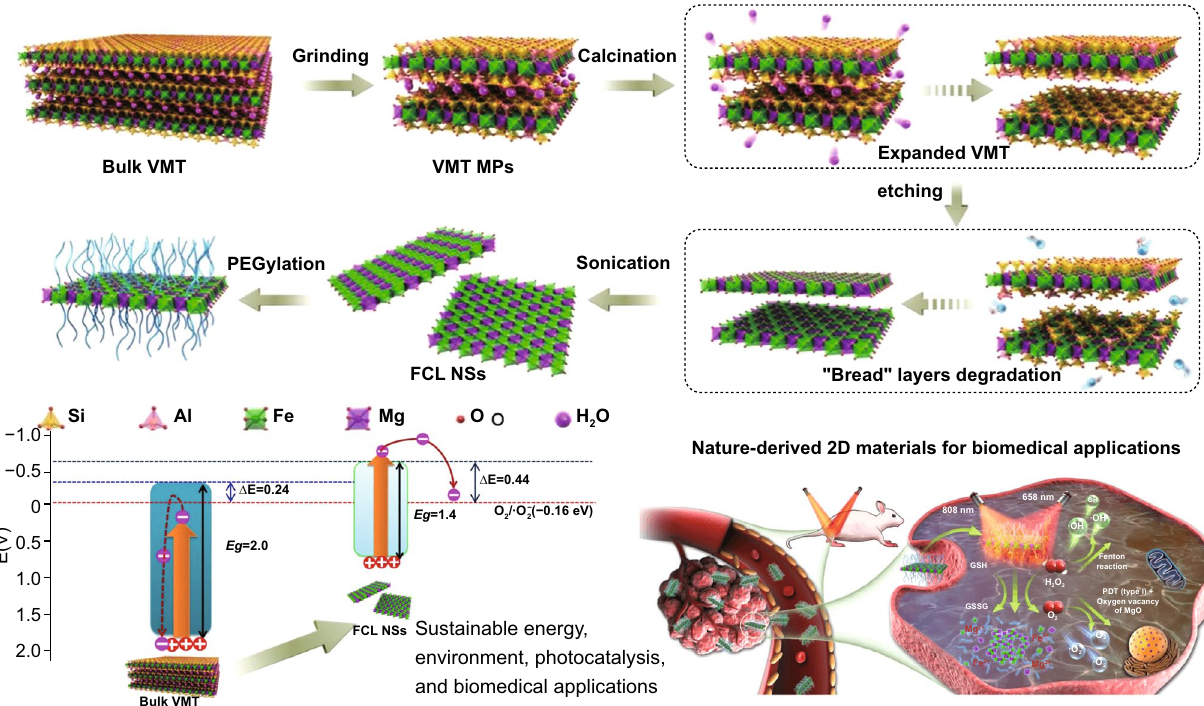
Fig. 11 Nature-derived 2D materials fabrication and PEGylation (reprint with permission from Nature Publishing Group